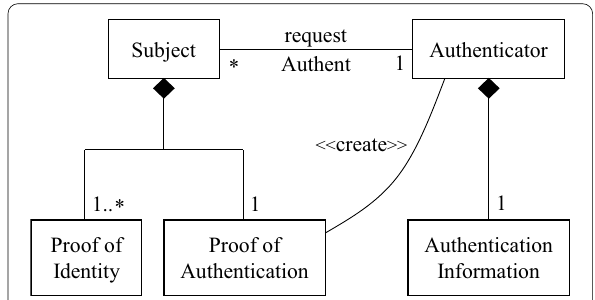
Fig. 1 Class diagram of the abstract authenticator pattern